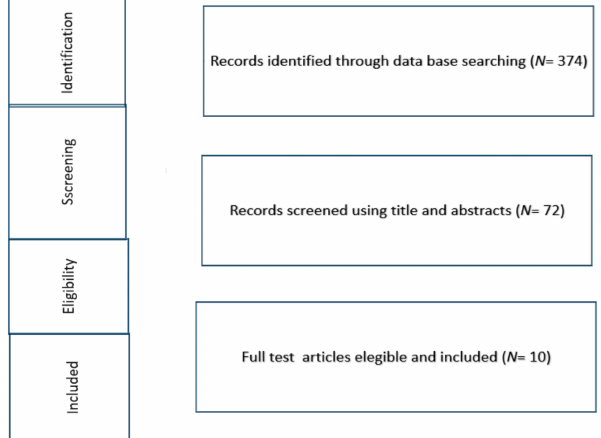
Figure 1. Flow chart that shows the selection of the